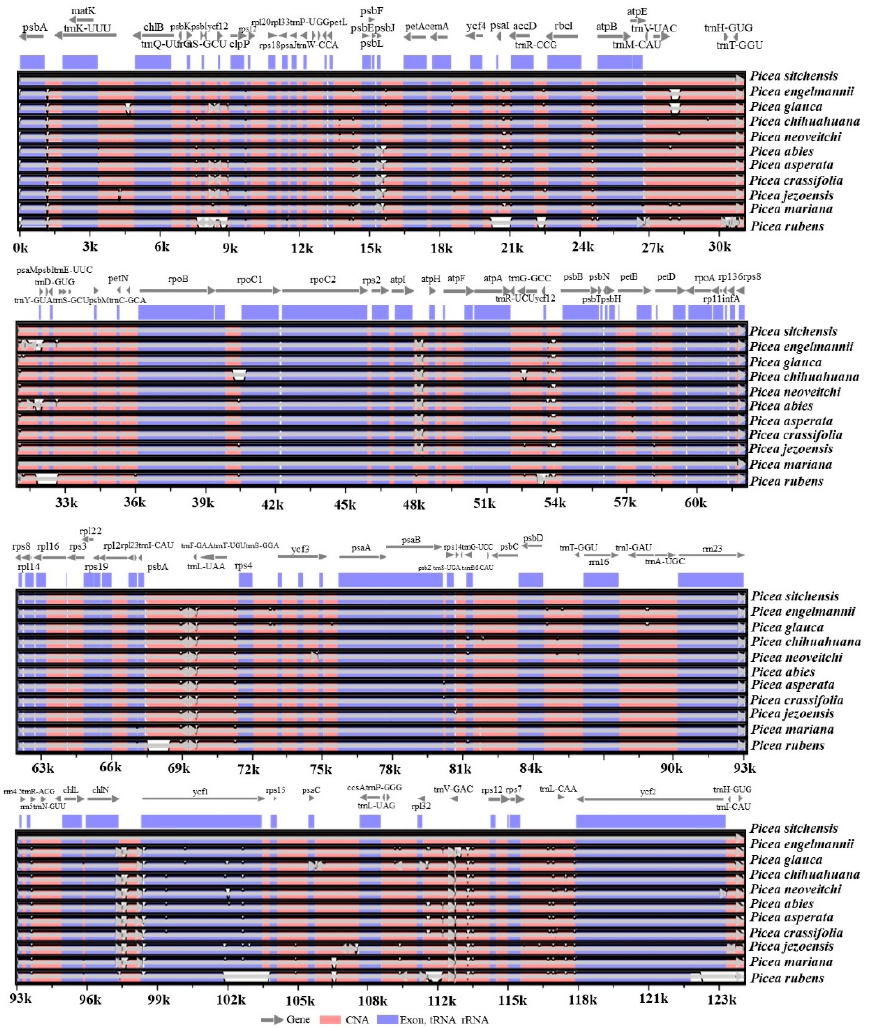
Figure 2. mVISTA-based visual representation of the aligned genomes of the 11 Picea species using annotation of the P. sitchensis chloroplast genome as the reference. The number of genes (107) annotated in the P. rubens chloroplast genome was the same as in P. jezoensis (107), lower than that annotated in the chloroplast genomes of P. sitchensis (114), P. mariana (114), P. glauca (114), P. engelmannii (114), P. neoveitchii (116), P. asperata (108), P. crassifolia (108), and P. abies (108), and higher than that annotated in P. chihuahuana